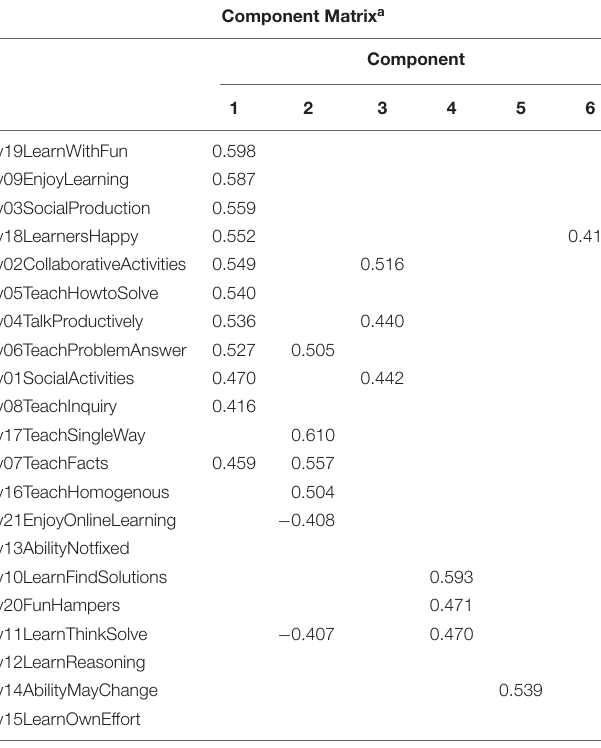
TABLE 2 | FA with Varimax rotation in SPSS. Rotated Component Matrix a